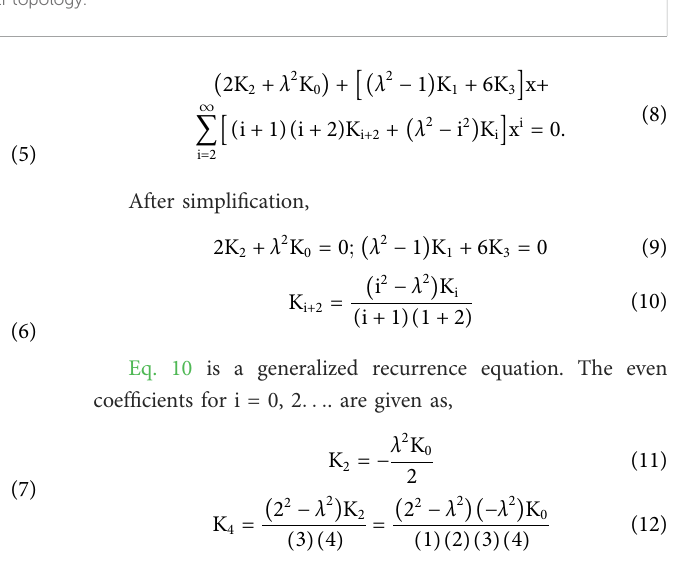
FIGURE 4 (A – G) : A 7 level of inverter voltage of the proposed 8S-TTB-MLI